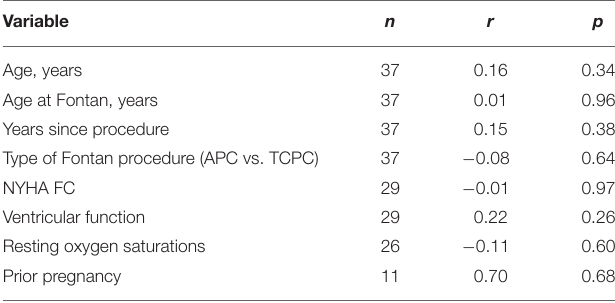
in this field, men with a Fontan circulation were infrequently included (15, 17, 26).